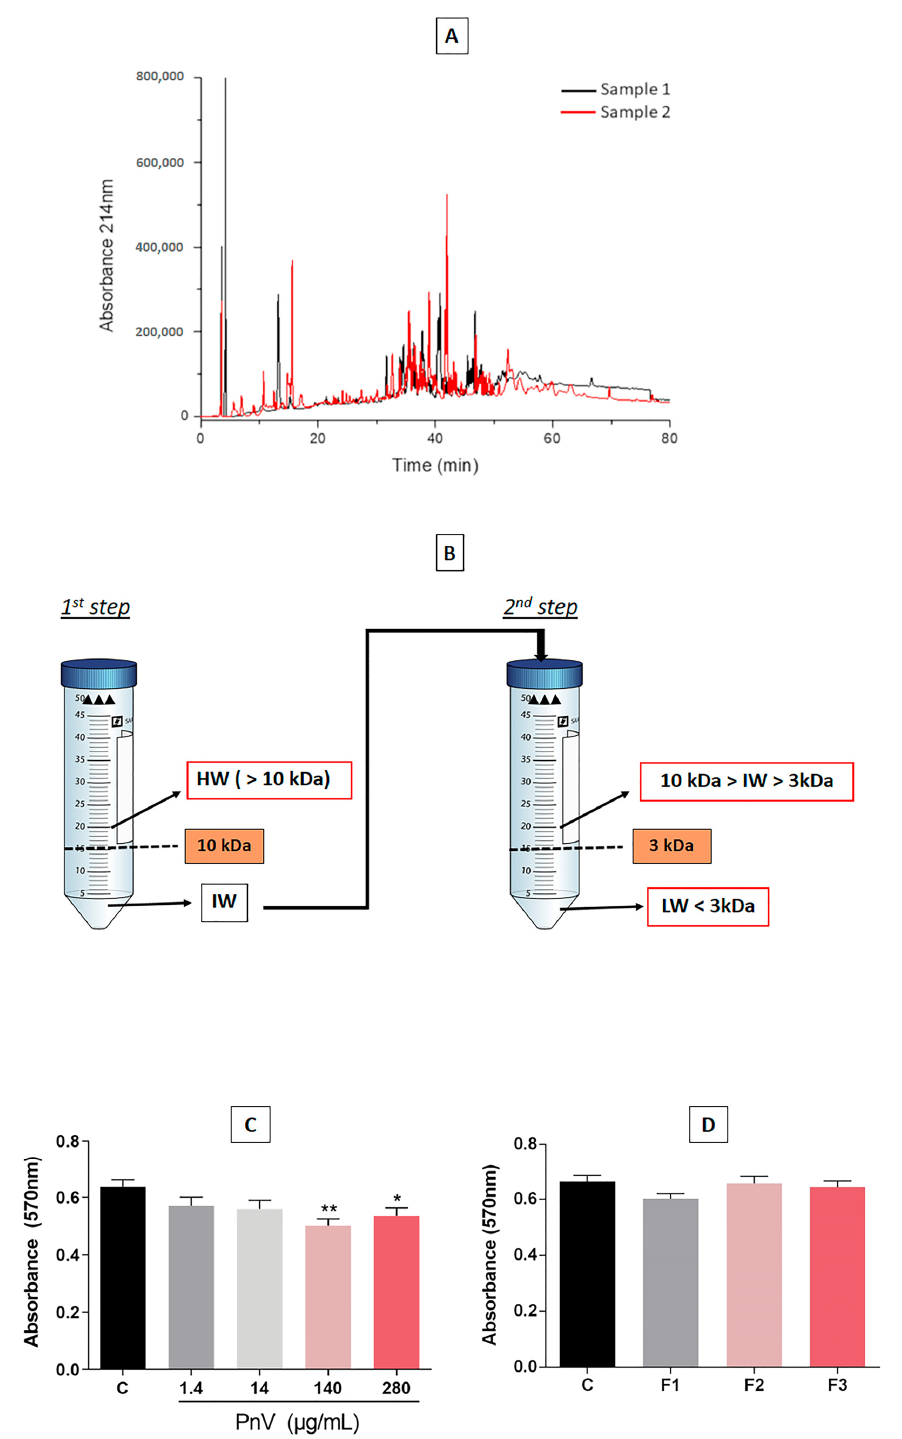
Figure 1. PnV profile obtained by high-pressure liquid chromatography (HPLC) and cell viability assay. The HPLC showed that there were no relevant differences between the two pooled venom samples used in this work ( A ). Stages of the first fractionation of PnV by molecular mass: HW = high weight (F3); IW = intermediate weight (F2); LW = low weight (F1) ( B ). Cell viability (MTT) analysis by the effect of PnV at different concentrations (1.4, 14, 140 and 280 µ g/mL) and fractions (F1, F2 and F3; 1 µ g/mL) in DCs in vitro after twenty-four hours incubation ( C , D ). Data were analyzed by one-way ANOVA and Kruskal–Wallis test. Unpaired Student’s t -test was used to compare each treatment with the control. * p < 0.05 and ** p < 0.01 compared to the untreated control. Data are presented as mean ± standard error (SEM). Results of three independent